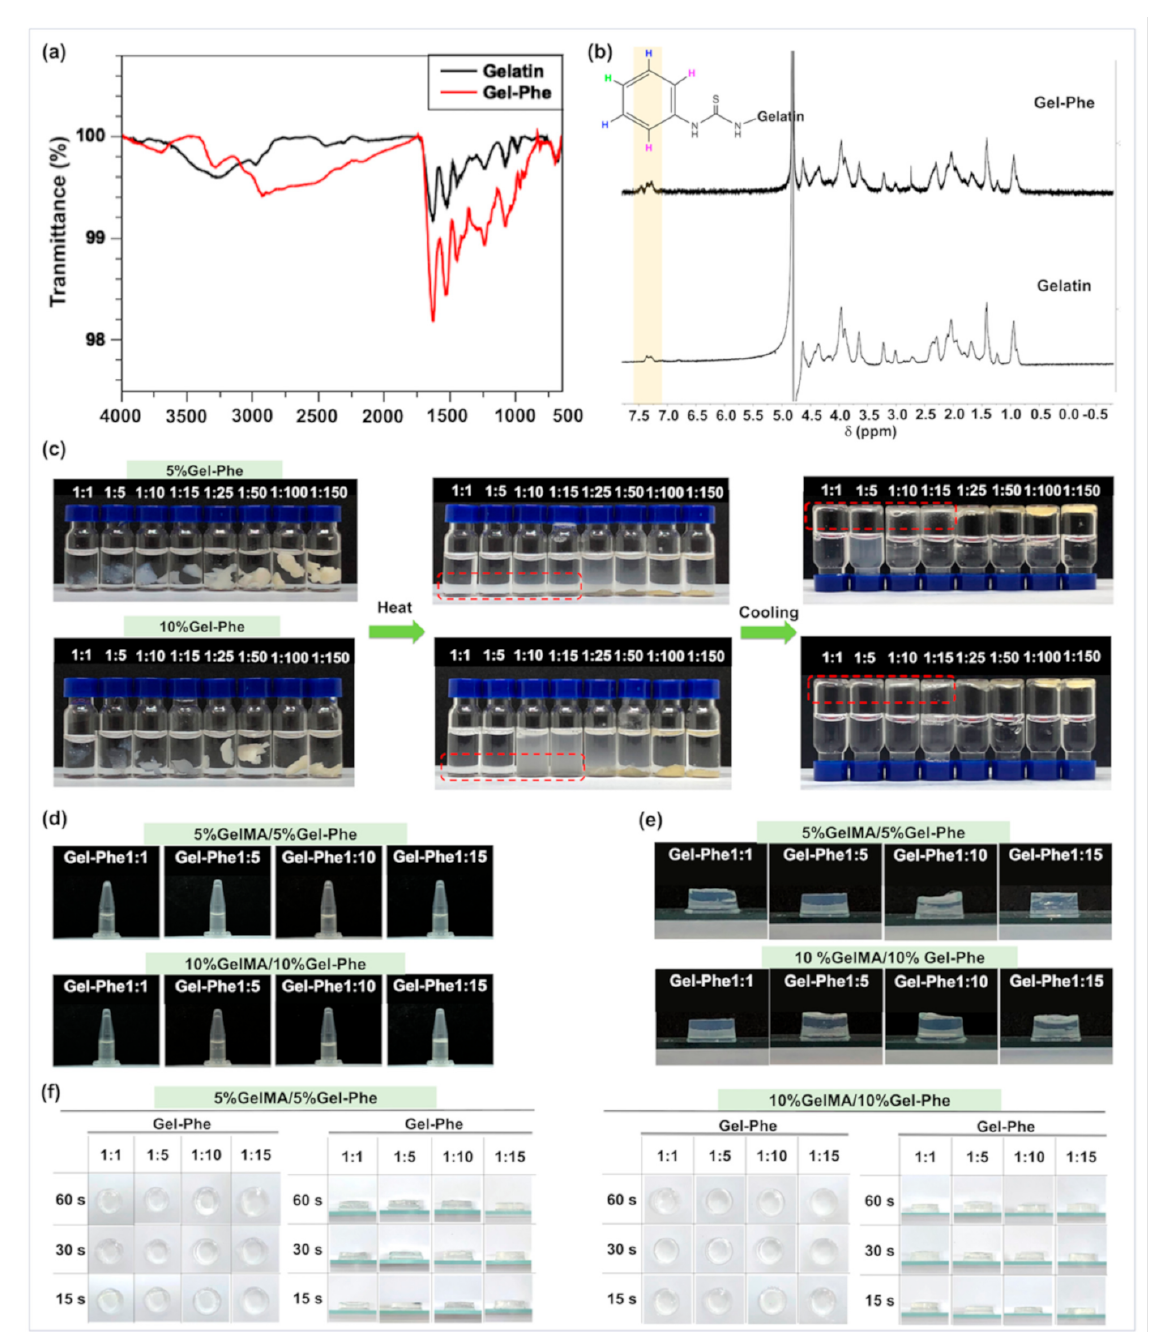
Figure 2. Characterization of gelatin and Gel-Phe. ( a ) The FTIR spectrum of gelatin and Gel-Phe showed characteristic relative peaks of functional groups. ( b ) The 1 H-NMR spectrum of gelatin and Gel-Phe validated the chemical modification of phenyl isothiocyanate grafted on the gelatin backbones. ( c ) The morphologies of Gel-Phe with different G/P ratios immersed in water after the heating–cooling process. Optical imaging showed the gel formation of Gel-Phe with different G/P ratios mixed with GelMA and 0.5% PI ( d ) before and ( e ) after UV light exposure. ( f ) The overhead view and side-view images showed the crosslinked hydrogel morphologies of GelMA/Gel-Phe solutions with 0.5% PI by treatment with different UV light exposure times (15, 30, and 60